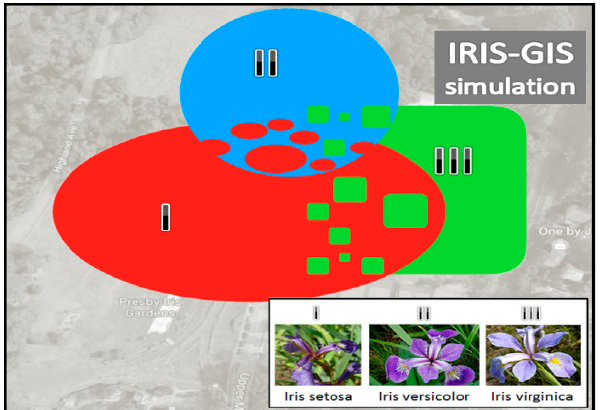
Figure 15. Injecting a spatial awareness into the Iris dataset. Samples of the three types of irises from the dataset were randomly placed within the three corresponding spatial areas (I, II, and III) on the map. Spatial coordinates have been added to the Iris dataset, which has been updated to the IRIS-GIS dataset as a result. Table 8. Results of the experiments with the Iris vs. IRIS-GIS datasets and the Wine vs. WINE-GIS datasets.